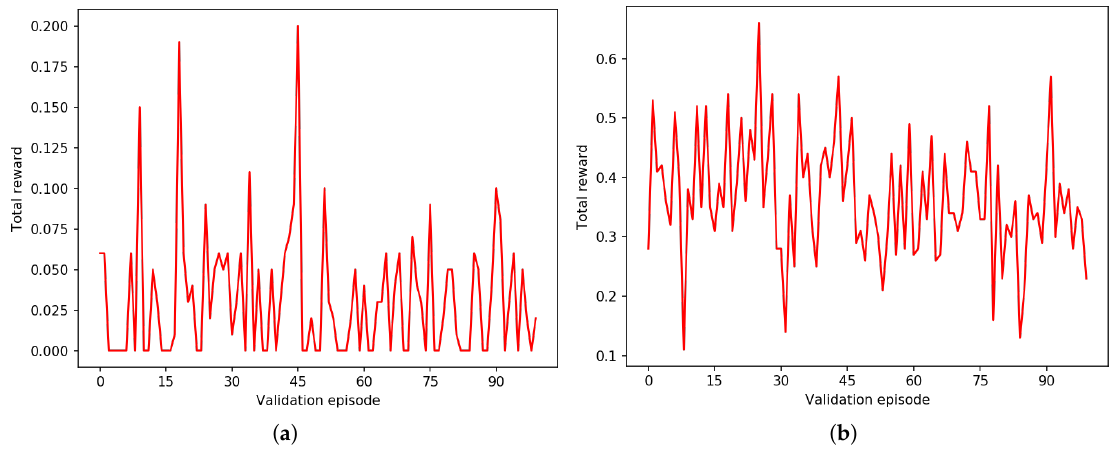
Figure 10. Average total rewards of a random agent on BF and RF for long sequences. ( a ) ρ BF with B = 400, episodes length T = 200. ( b ) ρ RF with N = 10, episodes length T =